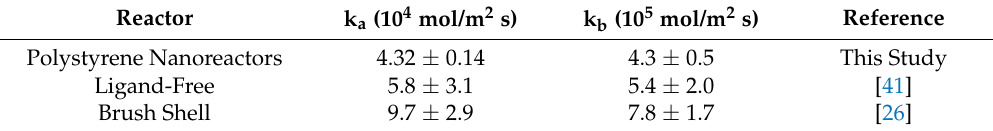
Table 3. Langmuir-Hinshelwood rate constants obtained from fits to experimental